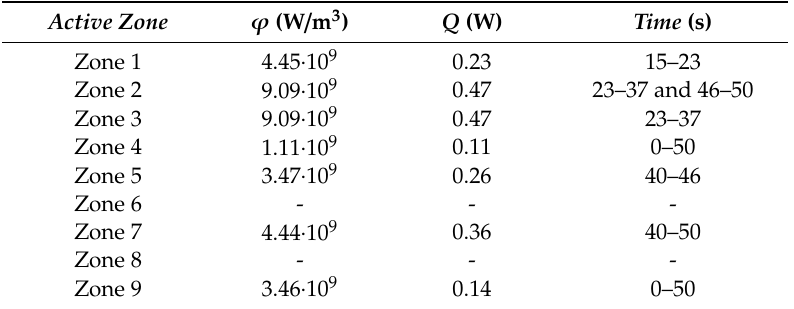
Table 9. Activation of the di ff erent zones of the chip for transient simulation number